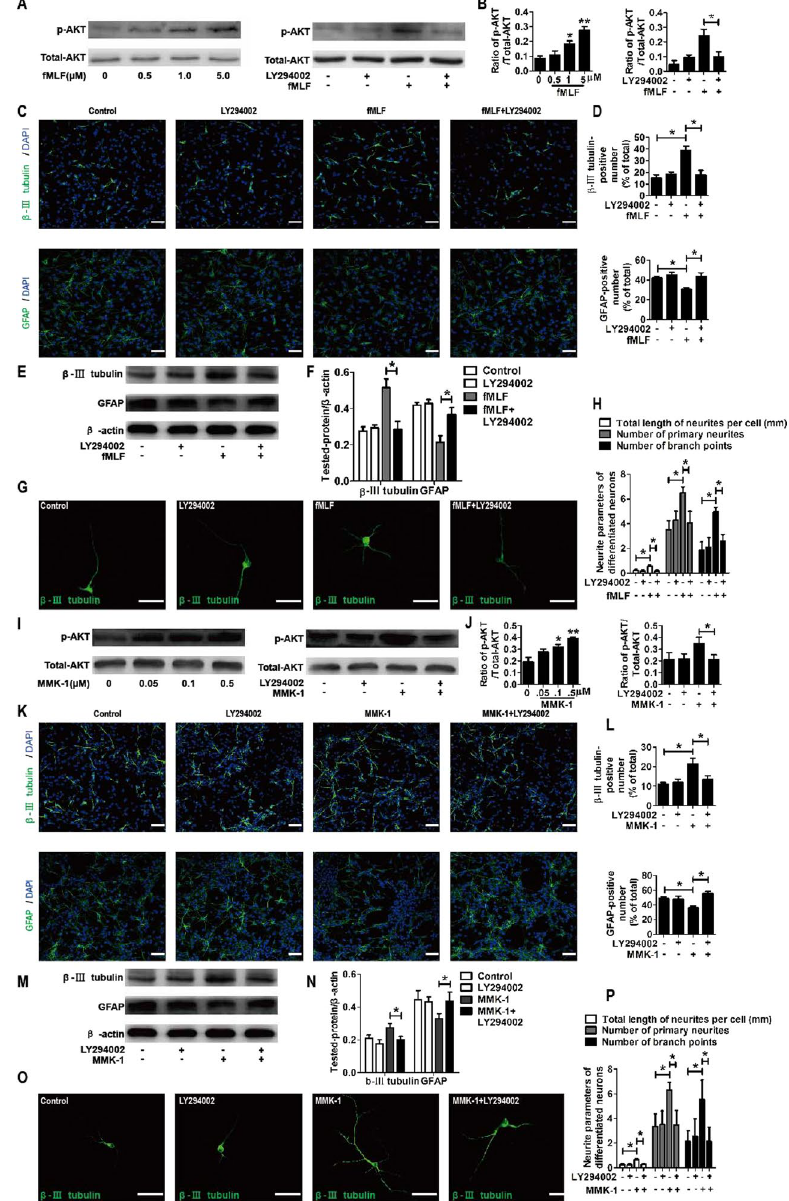
Figure 8. FPRs-induced neuronal differentiation of NSCs was mediated by the PI3K-AKT signaling pathway. ( A–H ) FPR1-induced neuronal differentiation of NSCs was mediated by the PI3K-AKT signaling pathway. ( A,B ) Western blot analysis of AKT activity in NSCs with or without preadministering LY294002 for 30 min before administering fMLF. ( A ) Representative immunoblots. ( B ) Relative quantification for AKT activity. ( C,D ) Dissociated NSCs were differentiated with or without preadministering LY294002 for 30 min before administering fMLF. The images in ( C ) are representative of several independent experiments, and the graph in ( D ) shows the statistical results. ( E ) Representative immunoblots. ( F ) Histograms showing relative levels of β -III tubulin and GFAP. ( G ) Dissociated NSCs were differentiated in an extremely low density (1000 cells/ mL), and then the cells were immunostained with β -III tubulin. ( H ) Quantified analysis of the total length of neurites per cell, the number of primary neurites, and the number of branch points. ( I–P ) FPR2-induced neuronal differentiation of NSCs was mediated by the PI3K-AKT signaling pathway. ( I,J ) Western blot analysis of AKT activity in NSCs with or without preadministering LY294002 for 30 min before administering MMK- 1. ( I ) Representative immunoblots. ( J ) Relative quantification for AKT activity. ( K,L ) Dissociated NSCs were differentiated with or without preadministering LY294002 for 30 min before administering MMK-1. The images in ( K ) are representative of several independent experiments, and the graph in ( L ) shows the statistical results. ( M ) Representative immunoblots. ( N ) Histograms showing relative levels of β -III tubulin and GFAP. ( O ) Representative micrographs of the differentiated cells immunostained with β -III tubulin. ( P ) Quantified analysis of the total length of neurites per cell, the number of primary neurites, and the number of branch points. Data were presented as mean ± SEM. * P < 0.05; ** P < 0.01; N = 4. Scale bar = 20 µ